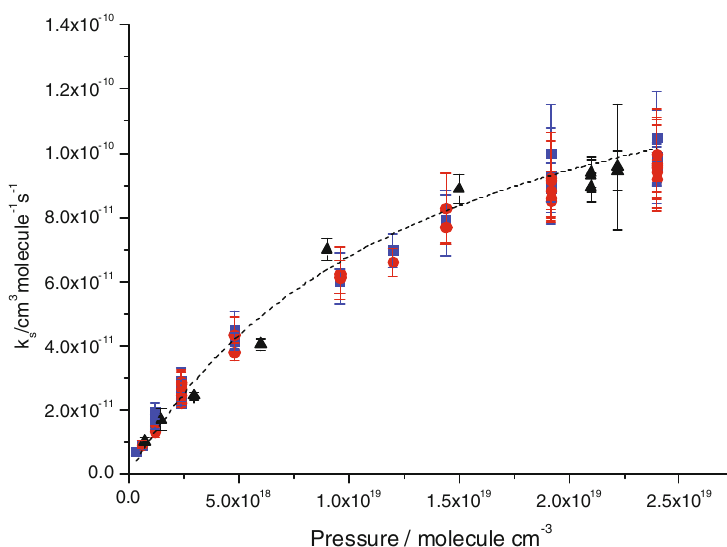
Fig. 6. Fall-o ff curve showing the rate of loss of Cl + ethene as a function of total pressure N 2 . (cid:2) and • represent the data obtained from relative rate with detection by FTIR and GC, respectively, and the corresponding Troe fit to these data. (cid:3) represents the data of Wallington et al.,